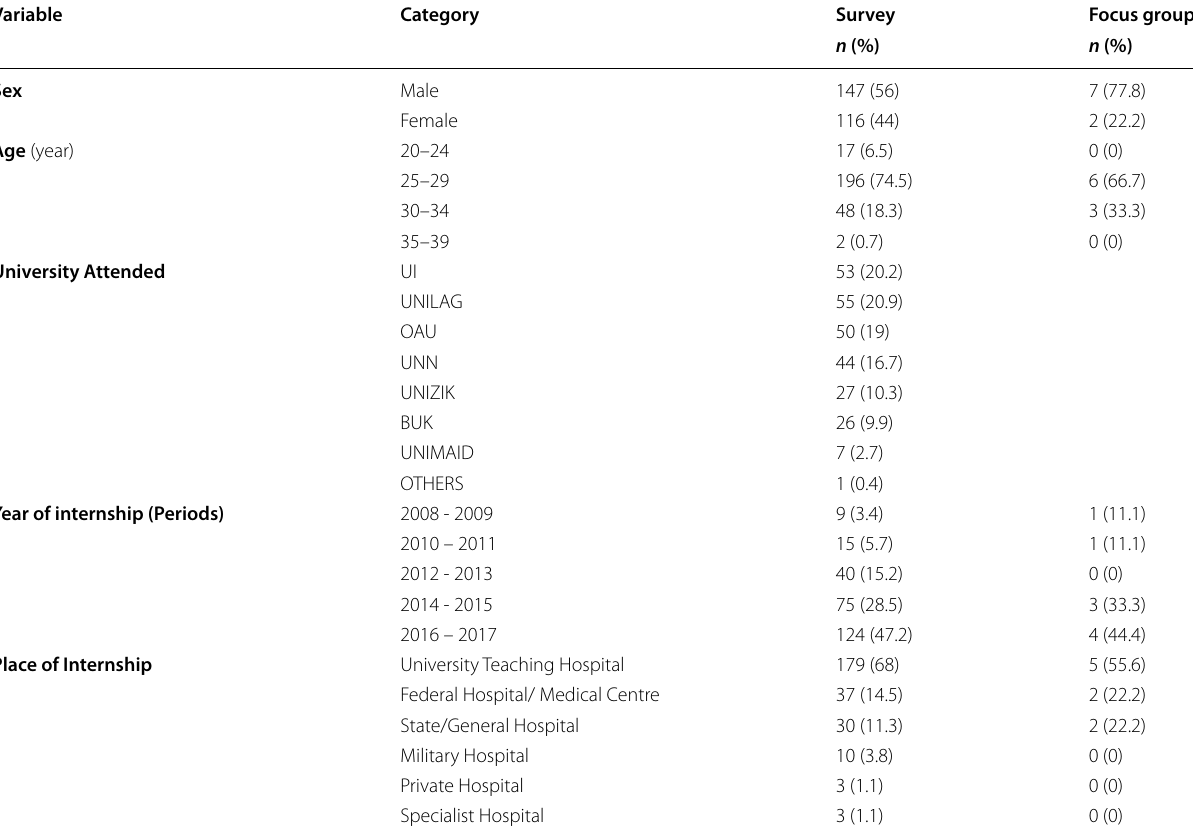
Table 2 Socio-demographic characteristics of the